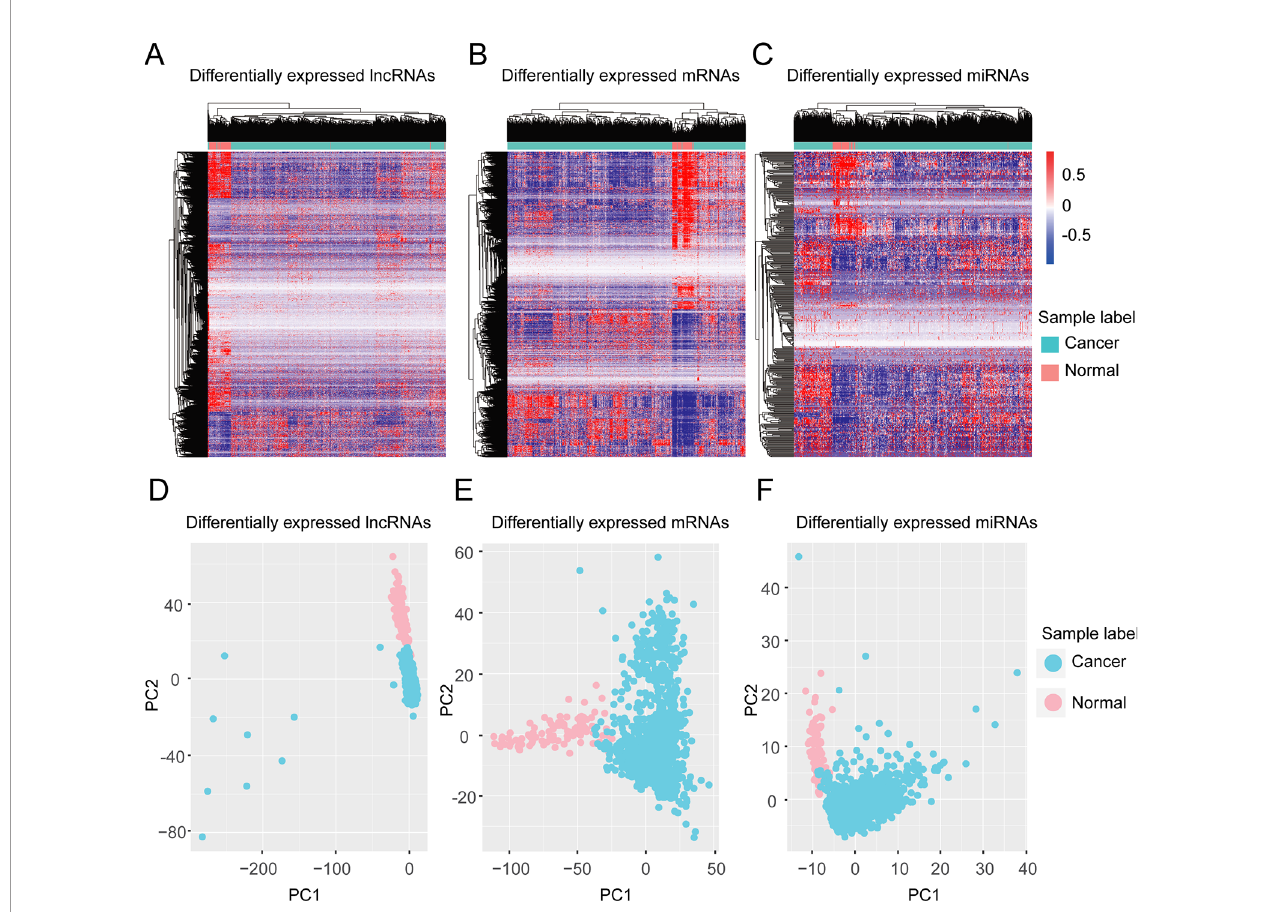
FIGURE 1 | Clustering based on differentially expressed molecules. Unsupervised hierarchical clustering of all samples based on differentially expressed lncRNAs (A) protein-coding genes (B) and miRNAs (C) . The unsupervised hierarchical clustering was performed using an R package, ‘ pheatmap ’ with the default distance setting, Euclidean distance. (D – F) PCA analysis based on differentially expressed lncRNAs (D) , protein-coding genes (E) , and miRNAs (F) . PCA analysis was performed by the R function ‘ prcomp ’